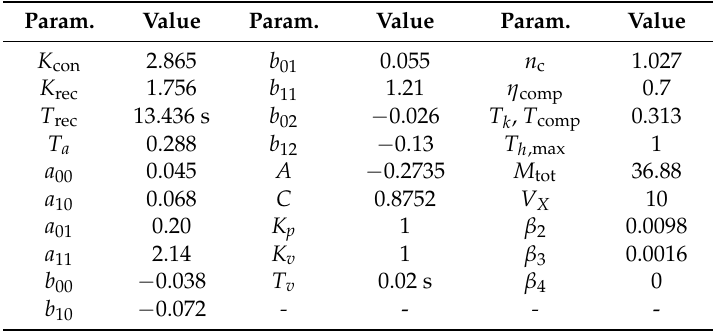
Table 2. Prime mover model and hydrogen supply system model parameters. Param. Value